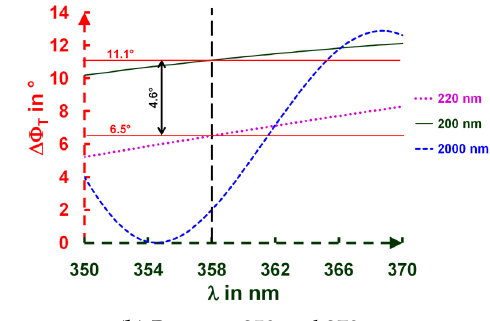
Figure 2. ( a ) Variation of the phase transmission as a function of wavelength for three-layer thicknesses (200, 220–corresponding to a 10% variation of the 200 nm layer–and 2000 nm) of colloidal silica with a refractive index of 1.22 and an extinction coefficient k of 10 –4 on a substrate having a refractive index of 1.5. ( b ) Zoom of Figure 2a between 350 and 370 nm.